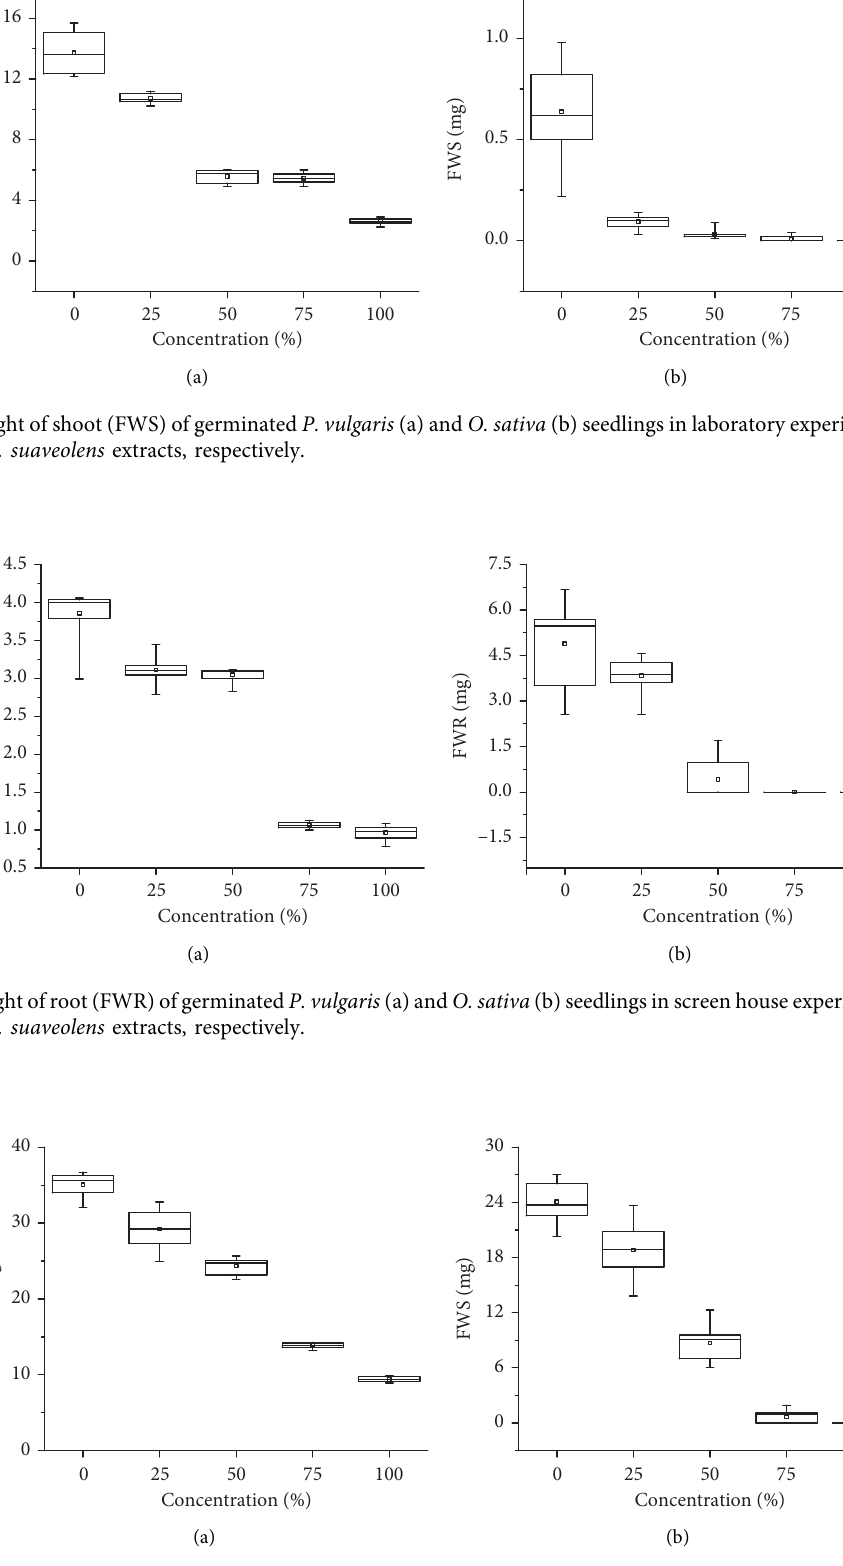
Figure 8: Fresh weight of shoot (FWS) of germinated P. vulgaris (a) and O. sativa (b) seedlings in screen house experiment after 7 and 14 days of treatment with S. suaveolens extracts,